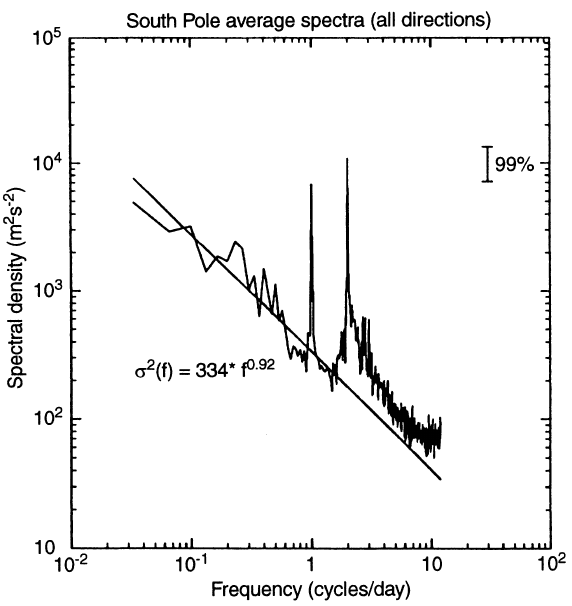
Fig. 7. The estimated South Pole power spectra for periods between 1h and 30 days averaged over all four azimuth directions. The solid line is an estimate of the spectral trend between 1 and 30 days assuming a f (cid:255) k type of dependence